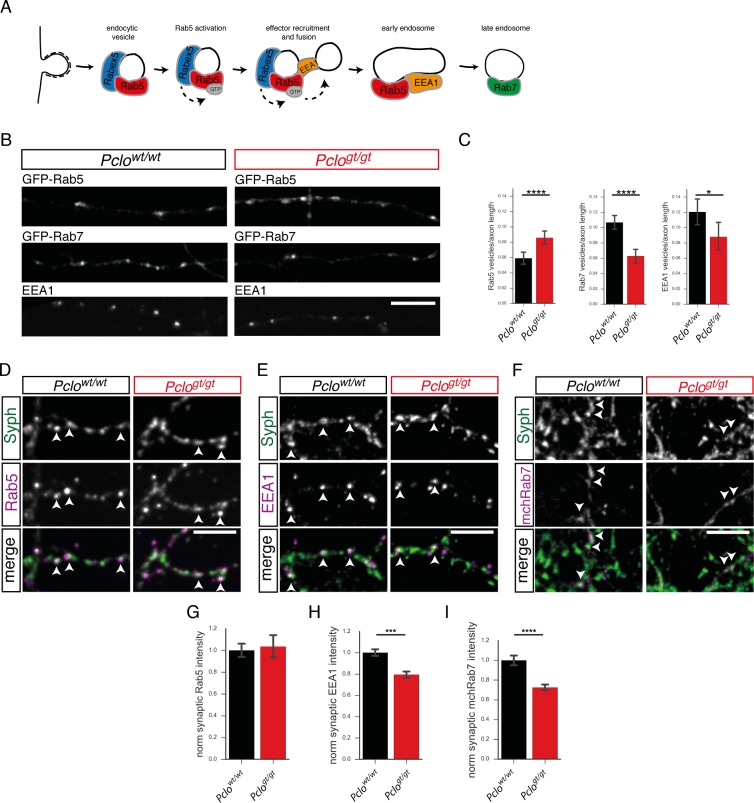
Levels of endosome proteins are reduced at synapses lacking Piccolo.(A) Schematic of SV membrane trafficking, illustrating when Rab5, EEA1 and Rab7 become associated with endosomal membranes. (B) Images of axon segments expressing GFP-Rab5 or GFP-Rab7 or immuno-stained with antibodies against EEA1. (C) Quantification of B. In Pclowt/wt neurons, fewer GFP-Rab5 puncta are present per unit length of axon (Pclowt/wt = 0.06 ± 0.004, n = 139 axon sections; Pclogt/gt = 0.08 ± 0.004, n = 143 axon sections; three independent experiments). In Pclowt/wt neurons, more GFP-Rab7 puncta are present per unit length of axon (Pclowt/wt = 0.11 ± 0.004, n = 139 axon sections; Pclogt/gt = 0.06 ± 0.004, n = 142 axon sections; two independent experiments). In Pclowt/wt neurons, more EEA1 positive puncta are present per unit length of axon compared to Pclogt/gt neurons (Pclowt/wt = 0.12 ± 0.01, n = 29 axon sections; Pclogt/gt = 0.09 ± 0.004, n = 34 axon sections; two independent experiments). (D–F) Immunocytochemical stainings of hippocampal neurons for endosome proteins. (D) Rab5 is present at Pclowt/wt and Pclogt/gt synapses, no differences in intensities are detectable. (E) EEA1 intensities are significantly reduced in Pclogt/gt synapses. (F) mChRab7 intensities are significantly reduced in Pclogt/gt synapses. (G–I) Quantification of (D–F). (G) The levels of Rab5 are not altered between Pclowt/wt and Pclogt/gt synapses (Pclowt/wt = 1 ± 0.03, n = 808 synapses; Pclogt/gt = 1.04 ± 0.05, n = 773 synapses; three independent experiments). (H) EEA1 intensity is significantly reduced in Pclogt/gt synapses (Pclowt/wt = 1 ± 0.02, n = 4323 synapses; Pclogt/gt = 0.79 ± 0.02, n = 3939 synapses; 10 independent experiments). (I) mChRab7 intensity is reduced in Pclogt/gt synapses (Pclowt/wt = 1 ± 0.03, n = 386 synapses; Pclogt/gt = 0.72 ± 0.02, n = 525 synapses; three independent experiments). Scale bar represents 10 μm. Error bars in bar graph represent 95% confidence intervals. Numbers given represent mean ± SEM, Student`s t -test. * denotes p<0.05, *** denotes p<0.001 and **** denotes p<0.0001.10.7554/eLife.46629.013Figure 4—source data 1.This spreadsheet contains the normalized values used to generate the bar plots shown in Figure 4C,H,I and J.